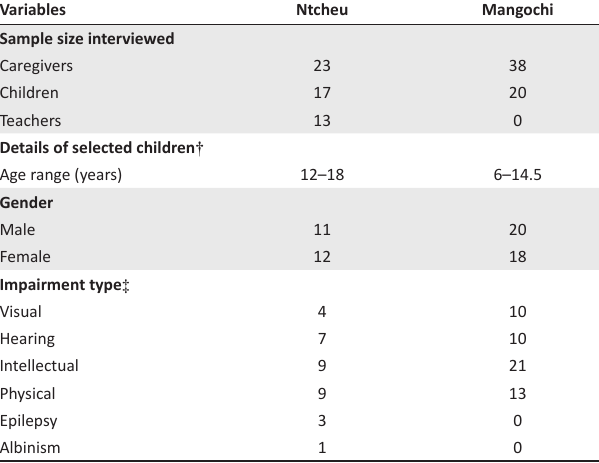
TABLE 1: Participant demographic